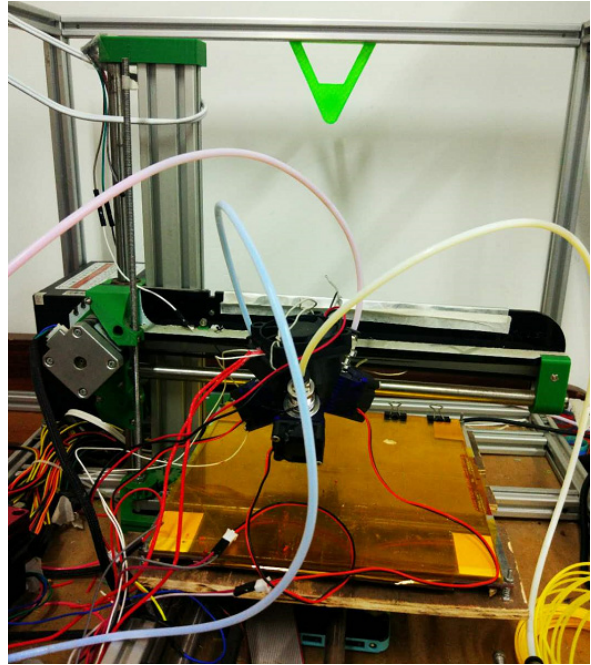
Figure 1. The whole structure of the color 3D printer.